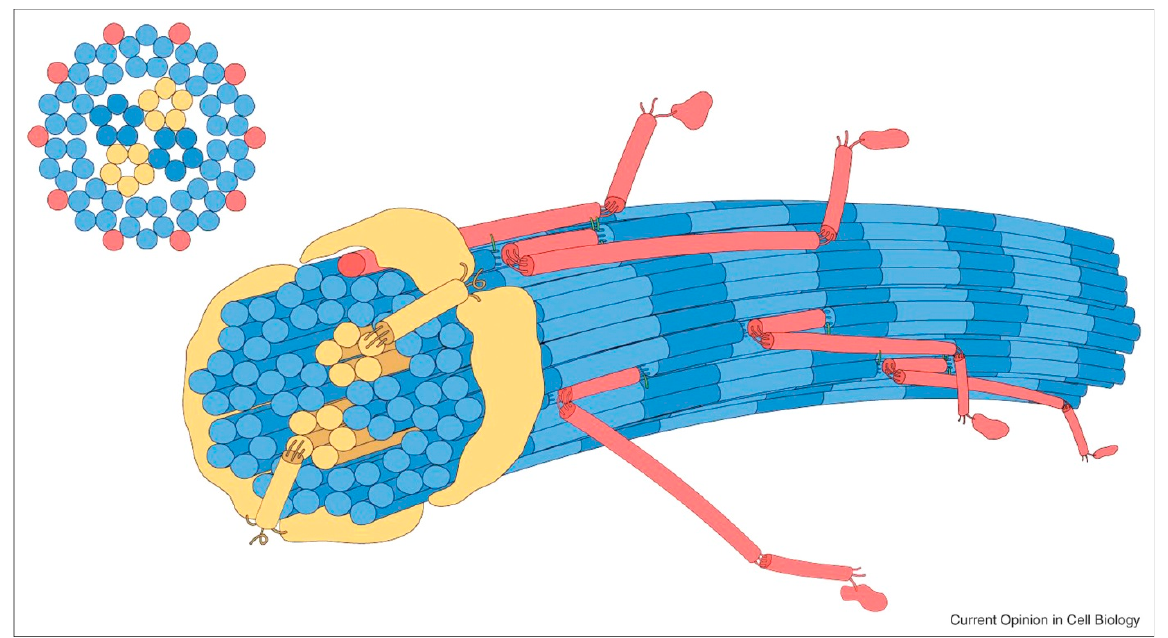
Figure 1. Schematic of the microfilament composition of collagen in cartilage. Blue: collagen II molecules; yellow: collagen XI molecules; red: collagen IX molecules. Collagen IX molecules project outwards and interact with the local environment. Adapted from [29] .